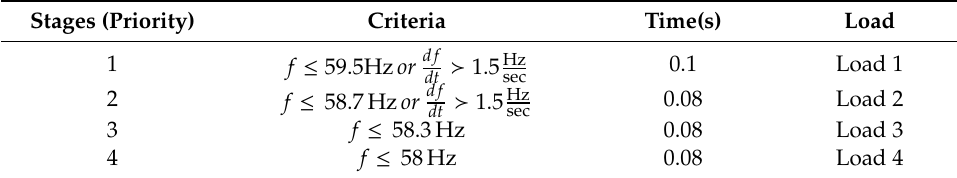
Table 3. Under Frequency Criteria for Load